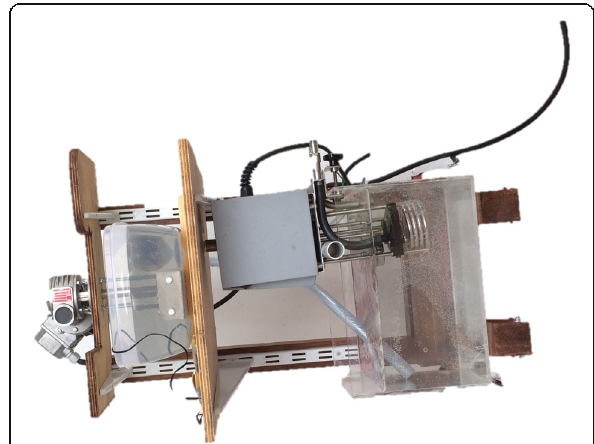
Fig. 2 Aging machine composed by the gear motor, the stainless steel support, water and saliva baths, and the heating pump